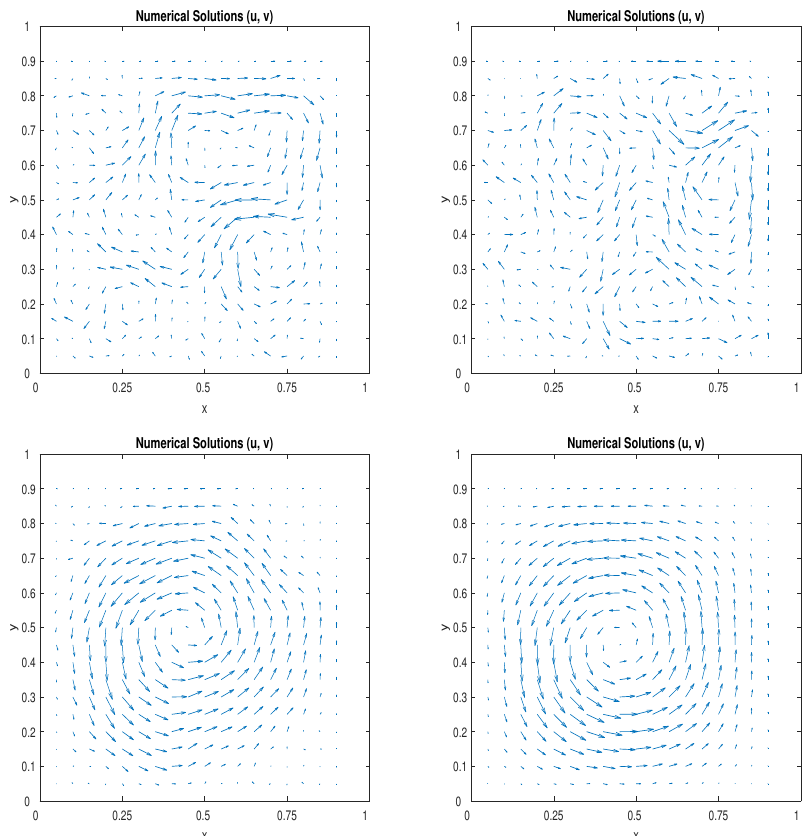
Figure 4. Optimal solution (velocity vector field): ( top left ) α = 10 − 1 ; ( top right ) α = 10 − 2 ; ( bottom left ) α = 10 − 3 ; and ( bottom right ) α = 10 − 4 on 18 2